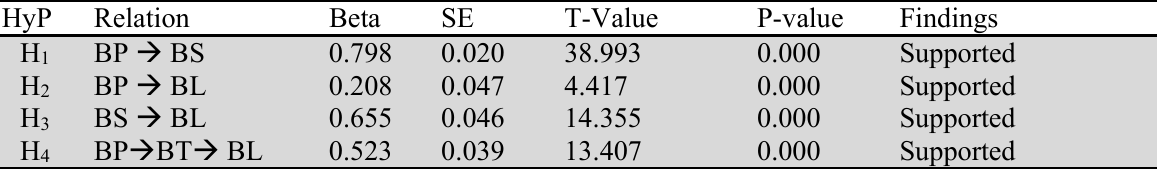
Structural Model Assessment with Mediator